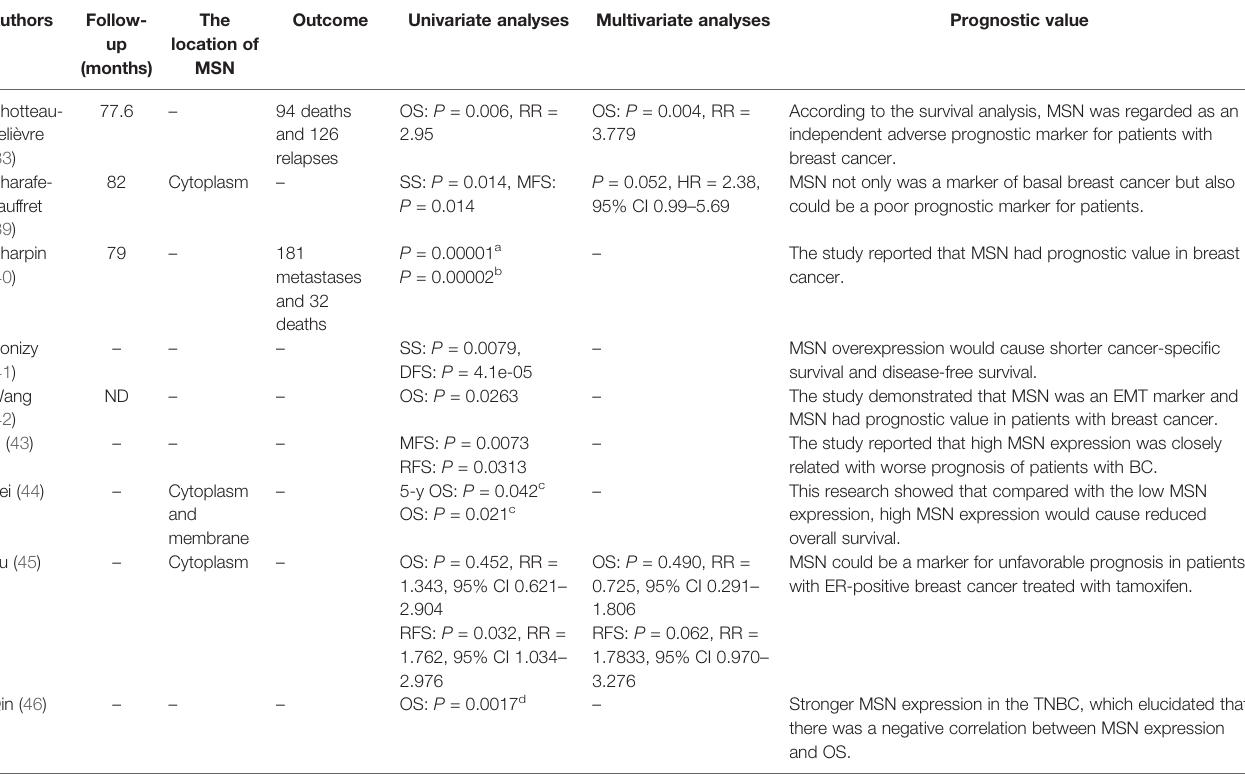
TABLE 3 | The association of high MSN expression and survival